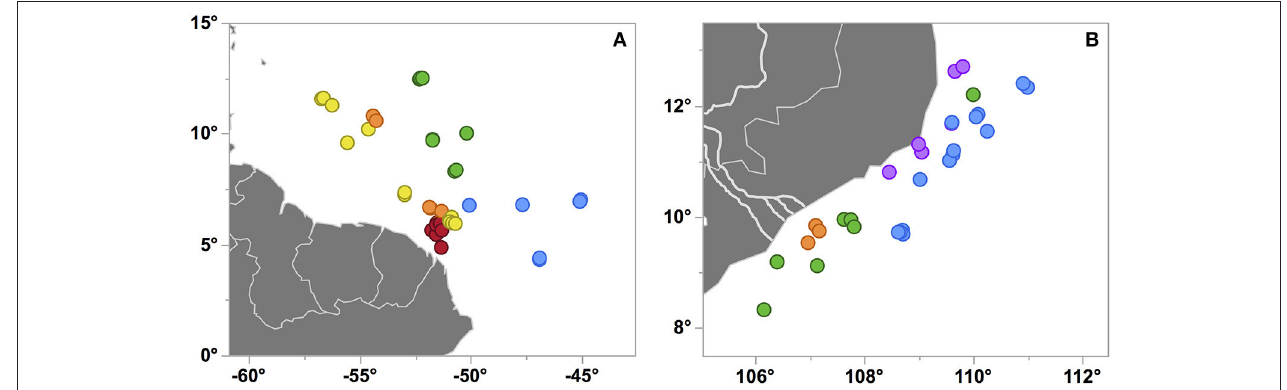
FIGURE 3 | Station maps of cruises KN197-8 in the WTNA (A) and FK160603 in the SCS (B) where each marker corresponds to a CTD cast. Markers are colored by habitat types as in Figures 2 , 5 , respectively, and are slightly jittered to reveal some of the overlapping markers. The Mekong River in panel (B) is represented by the bold white lines.